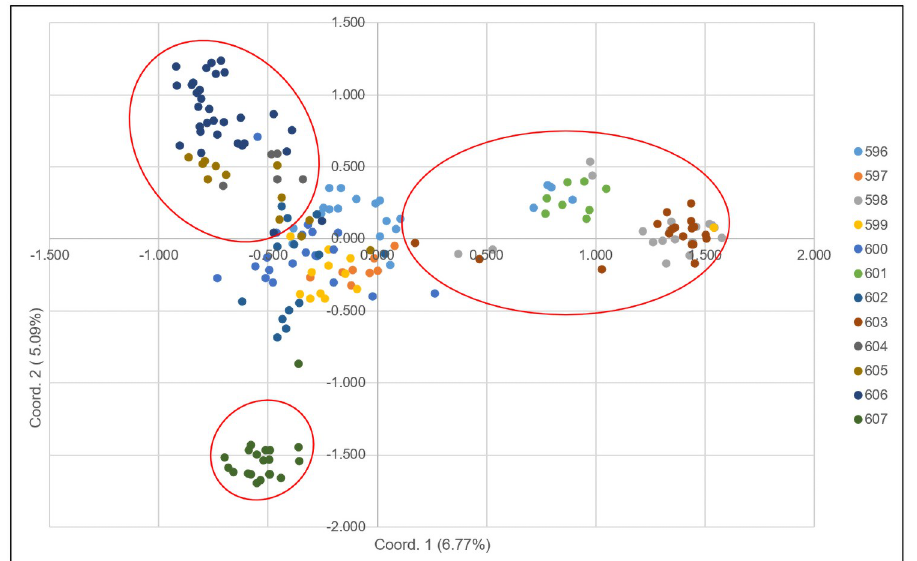
Fig 2. The principal coordinate analysis (PCoA) using genetic distance.